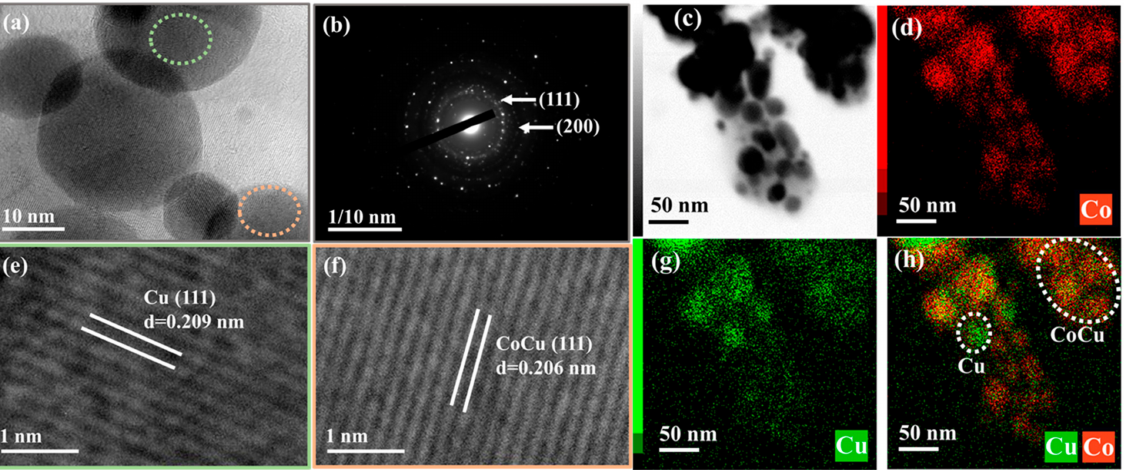
Figure 6. ( a , e , f ) Representative HRTEM images with ( b ) diffraction patterns and ( c , d , g , h ) EDS mapping of the reduced Co 1.40 Cu 1 /CaO